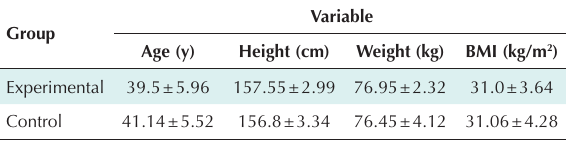
Table 2. Demographic Characteristics of the Subjects in the Study Groups Variable Group Age (y) Height (cm) Weight (kg) BMI (kg/m 2